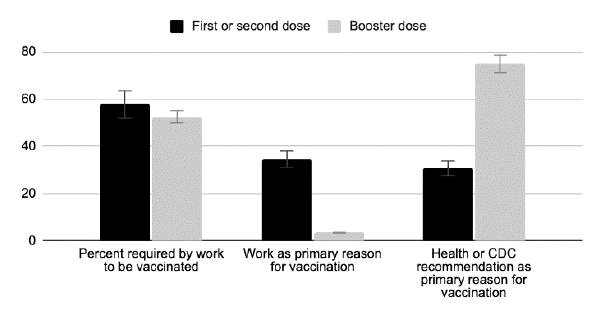
Figure . Mean Knowledge Score Across Demographic